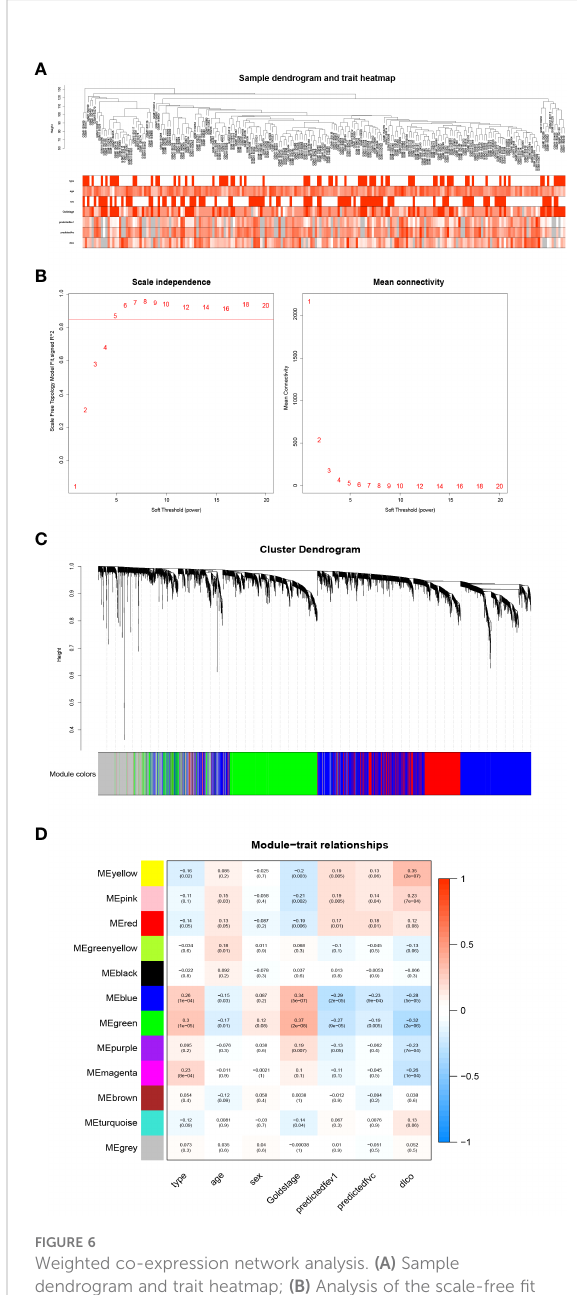
FIGURE 6 Weighted co-expression network analysis. (A) Sample dendrogram and trait heatmap; (B) Analysis of the scale-free fi t index (left) and the mean connectivity (right) for various soft- thresholding powers; (C) Clustering dendrograms of genes based on a dissimilarity measure; (D) Module-trait associations were evaluated by correlations between module eigengenes and sample non-emphysematous lung tissues. In contrast, the expression level of PTX3 did not show a signi fi cant difference (p<0.05, Figure 9), consistent with their expression trend in the bioinformatics analysis.